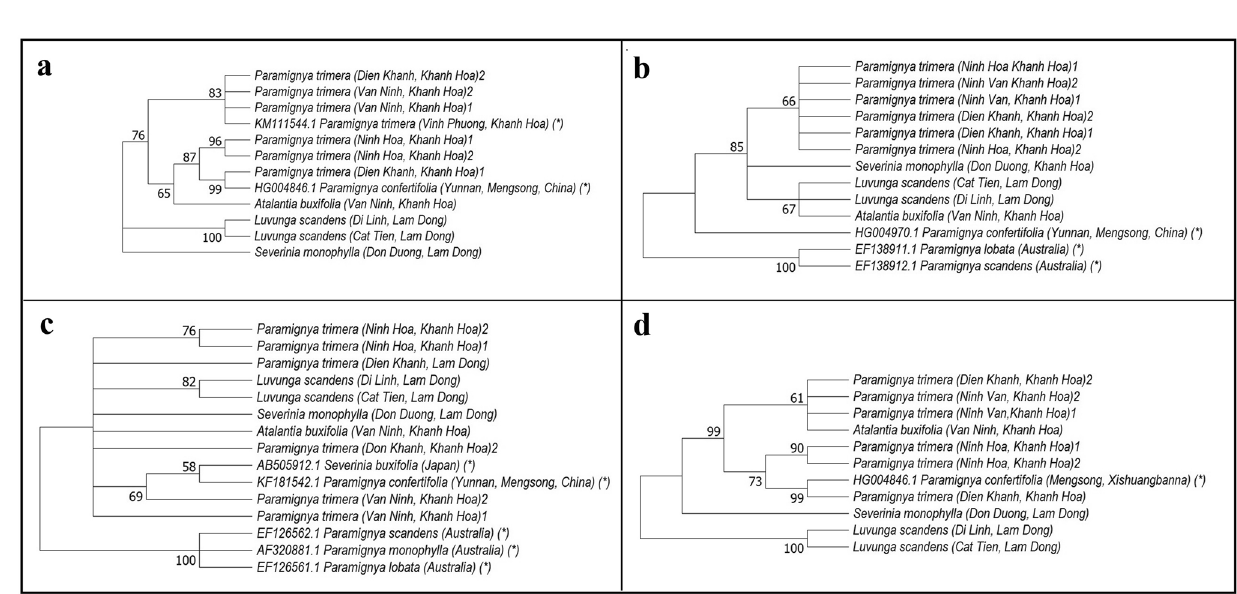
Figure 5. Condensed cladogram showing phylogenetic relationships of the accessions of P. trimera and relatives from DNA barcode sequences. Trees constructed from ITS ( a ), matK ( b ), rbcL ( c ) and concatenated sequences ( d ) using maximum likelihood (numbers at nodes are maximum likelihood bootstrap support values; branches with bootstrap support < 60 collapsed). The sequence data retrieved from GenBank with accession numbers were marked with asterisks